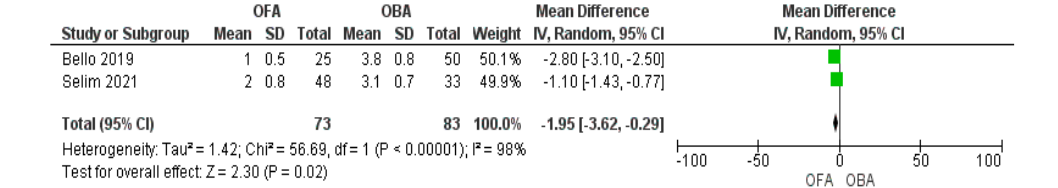
Figure 7. Forest plot of mean difference of pain at 48 h comparing opioid − free anesthesia and opi- oid − based anesthesia